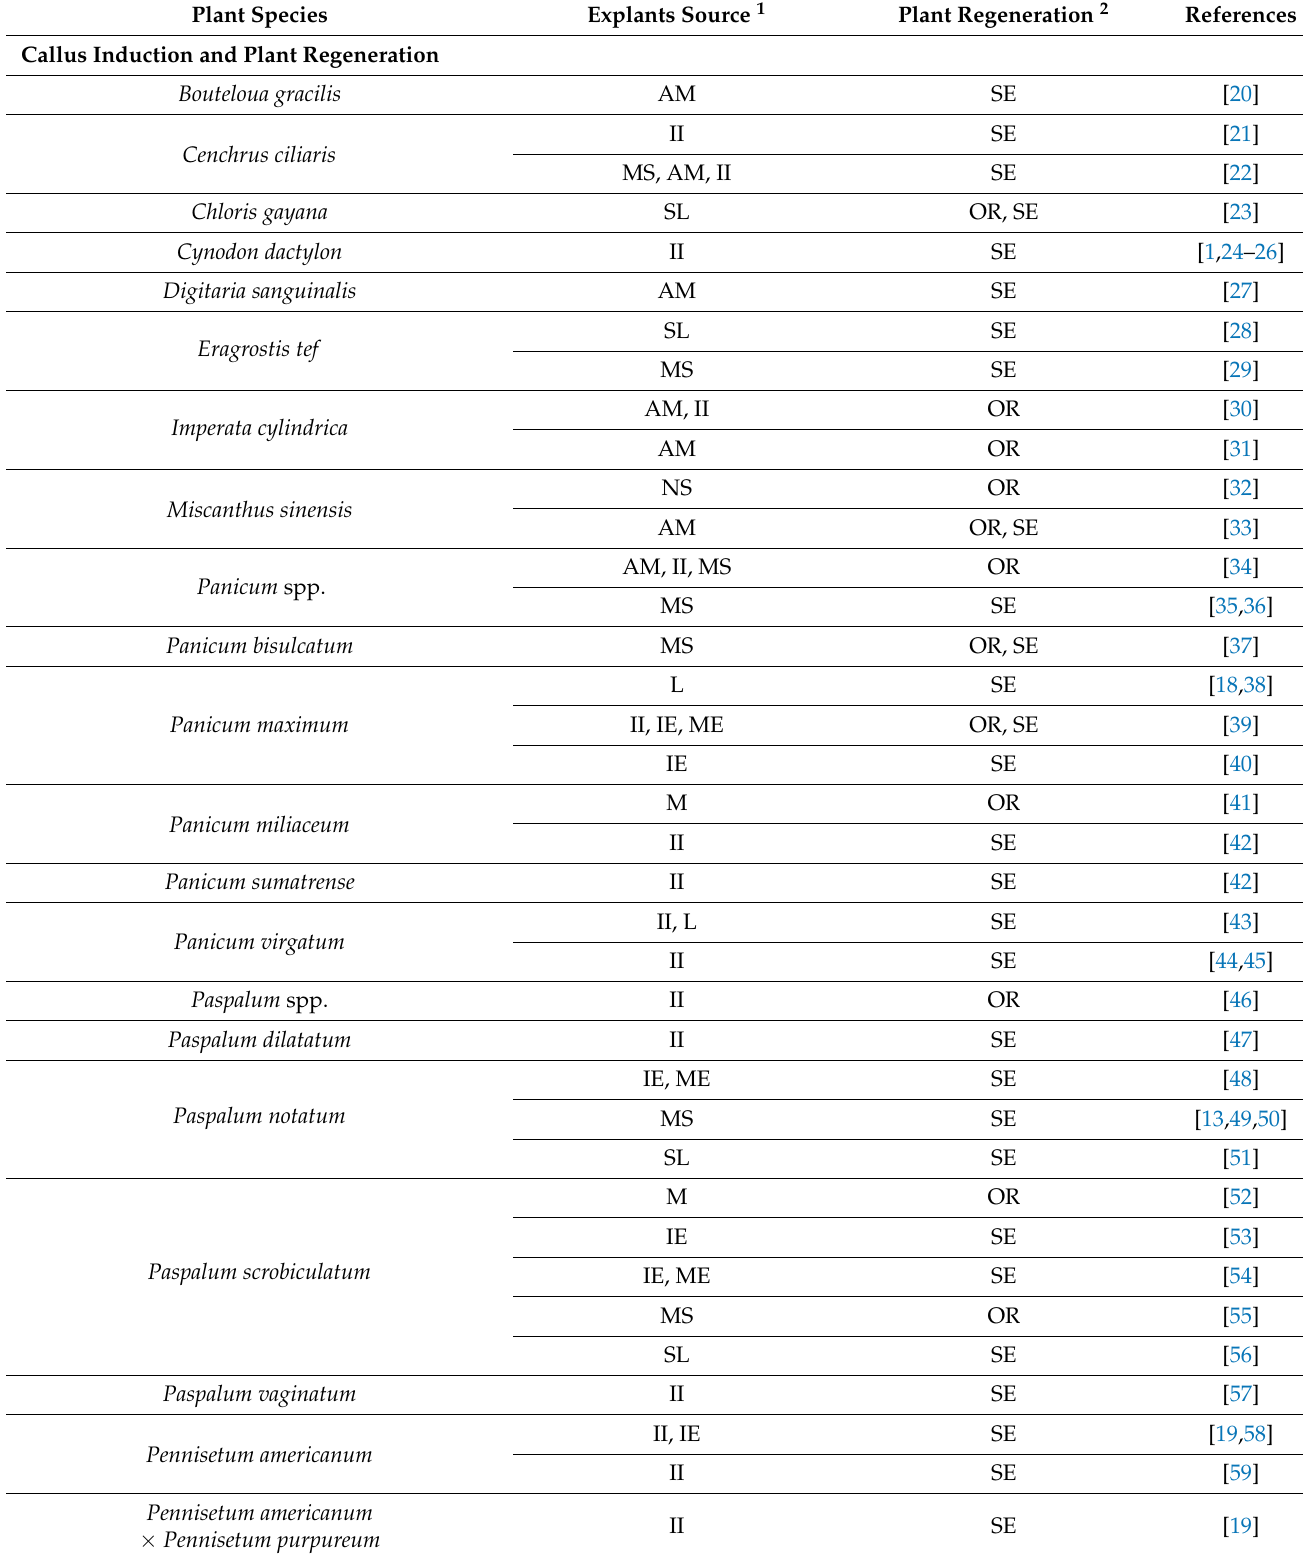
Table 1. Summary of tissue and protoplast cultures in warm-season grasses. Plant